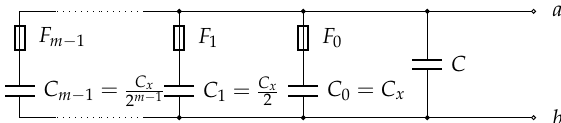
Figure 1. Fuse-based trimmable